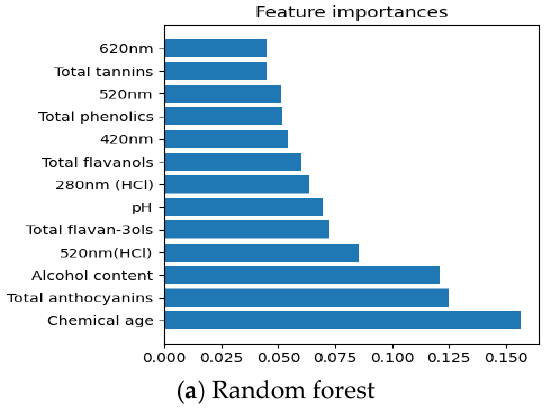
( d ) Extreme gradient boost Figure 4. Features selection of 13 chemical data using Random forest, Extra trees classifier, Gradi- ent boosting classifier, and Extreme gradient boost in vintages (old/new vintages). ( a – d ) display the important chemical parameters in Vintage Points that are selected by Random Forest, Extra trees classifier, Gradient boosting classifier and Extreme gradient boost, respectively. Surprisingly, alcohol content is also a significant chemical data for describing the vintage characteristics of New Zealand Pinot noir wines. In alcoholic beverages, yeast ferments hexose sugars (fructose, glucose) sourced primarily from grapes to produce ethanol [54]. During ageing, the alcohol level of Pinot noir wines may undergo interac- tions with carboxylic acid functional groups to form esters [55]. 3.1.3. Soft Sensors Predicting New Zealand Pinot Noir Wines’ Prices Building Soft Sensors to Predict New Zealand Pinot Noir Wines’ Prices The soft sensor using a decision tree was shown to be a reasonable classification model for predicting New Zealand Pinot noir wines’ high price (>60 NZ dollars), middle price (30 – 60 NZ dollars) and low price (<30 NZ dollars) based on 13 chemical data of 39 samples (total 117 bottles) New Zealand Pinot noir wines. The soft sensor using Naive Bayes had a better prediction accuracy in predicting New Zealand Pinot noir wines’ ac- tual price compared to other machine learning methods, including SVM, decision tree, Naive Bayes and KNN based on the chemical data of 117 bottles of New Zealand Pinot noir wines. Referring to the explanation from Figure 1, it could be inferred that, among 117 bot- tles Pinot noir wines, 15 bottles New Zealand Pinot noir wines with high prices, 60 bottles